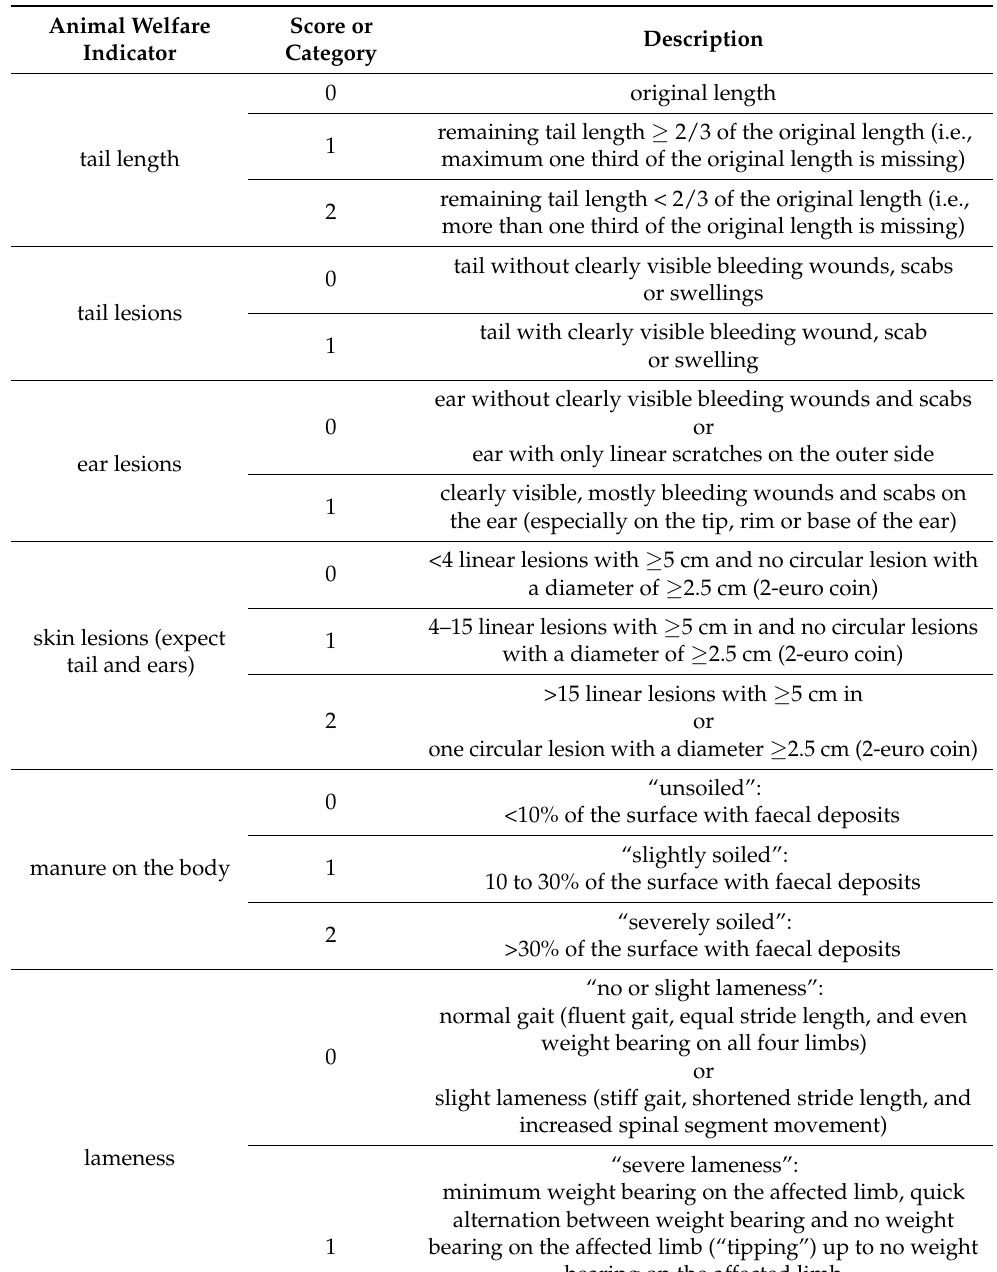
Table 2. Animal-based parameters according to the KTBL guideline